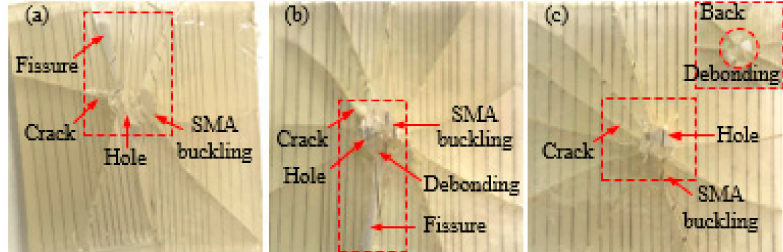
Figure 8. The failure modes diagrams of specimens with different SMA diameters under 14 J of energy: ( a – c ) indicate the SMA reinforced resin-matrix test specimens with SMA diameters of 0.3, 0.4, 0.5 mm, respectively.